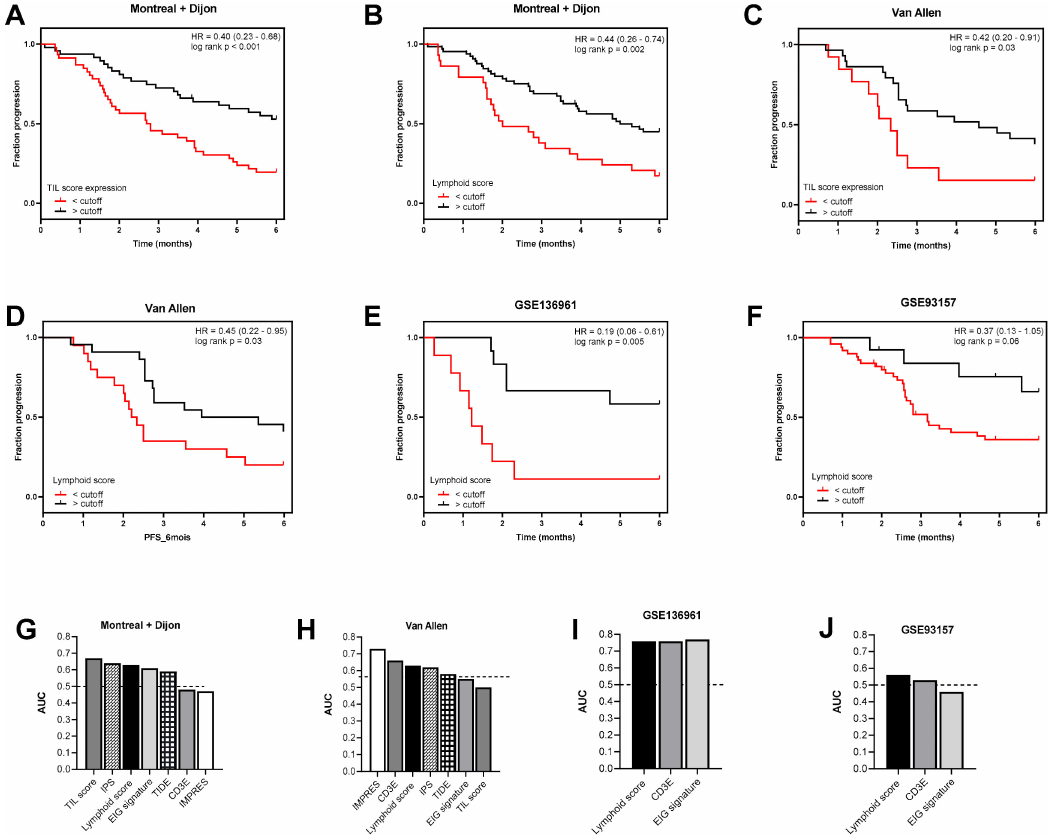
Figure 5. Prognostic role of TIL and lymphoid scores in comparison to other scores in a control cohort. ( A – F ): Kaplan–Meier survival analysis based on the TIL ( A , C ) and lymphoid ( B , D – F ) scores for progression-free survival; patients from the pooled Montreal and Dijon cohort ( A , B ), Van Allen ( C , D ), GSE136961( E ),andGSE93157( F )werestratifiedaccordingtothecuto ff obtainedfrommaximallyselected rank statistics. ( G – J ): Bar plots showing area under the curve (AUC) estimated for progression-free interval in univariate survival models involving TIL, lymphoid, IMPRES, IPS, and Tumor Immune Dysfunction and Exclusion (TIDE) scores (when score was available), CD8A genes and EIG signature for pooled Montreal and Dijon ( G ), Van Allen ( H ), GSE136961 ( I ), and GSE93157 ( J )